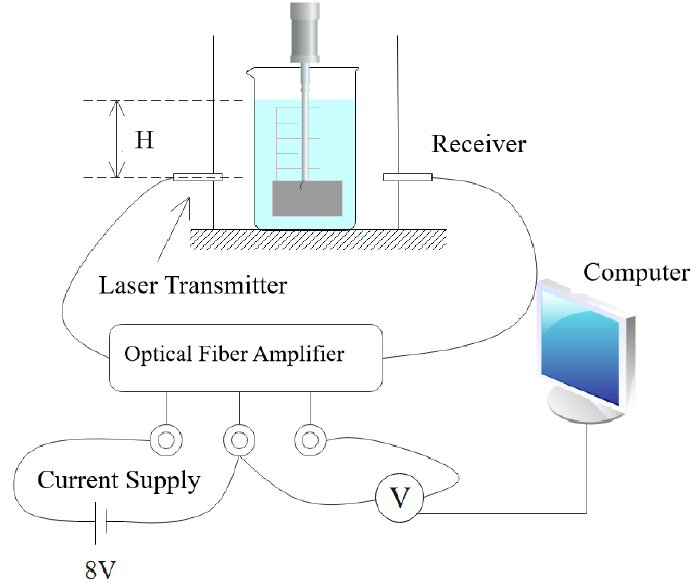
Figure 1. Schematic of real-time measuring setup.